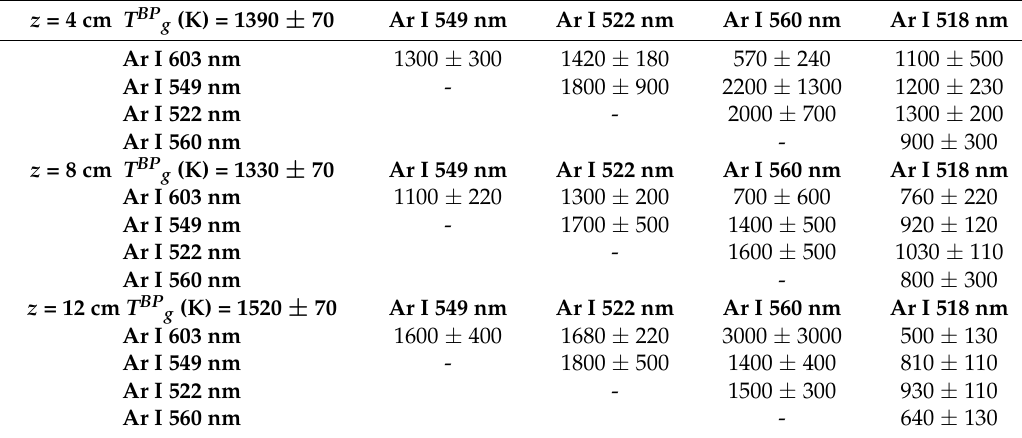
Table 3. Gas temperature obtained using Equation (14) with theoretical Stark broadening parameters at electron temperatures of 10,000 K, and comparison with the one obtained from OH ro-vibrational bands, using the well known Boltzmann plot